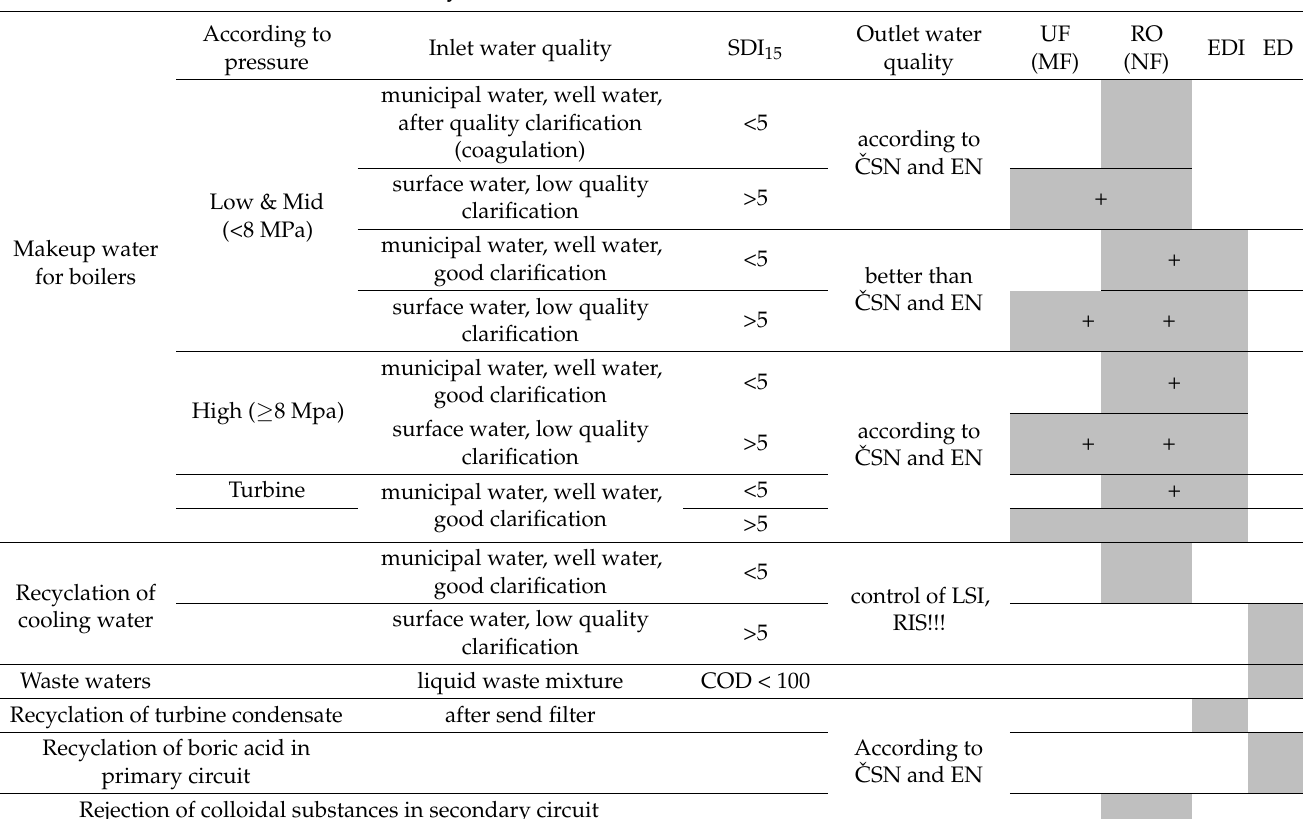
Table 8. Industry proven water treatment processes in power generation sector regarding their technical and economic feasibility (list of abbreviations bellow, page